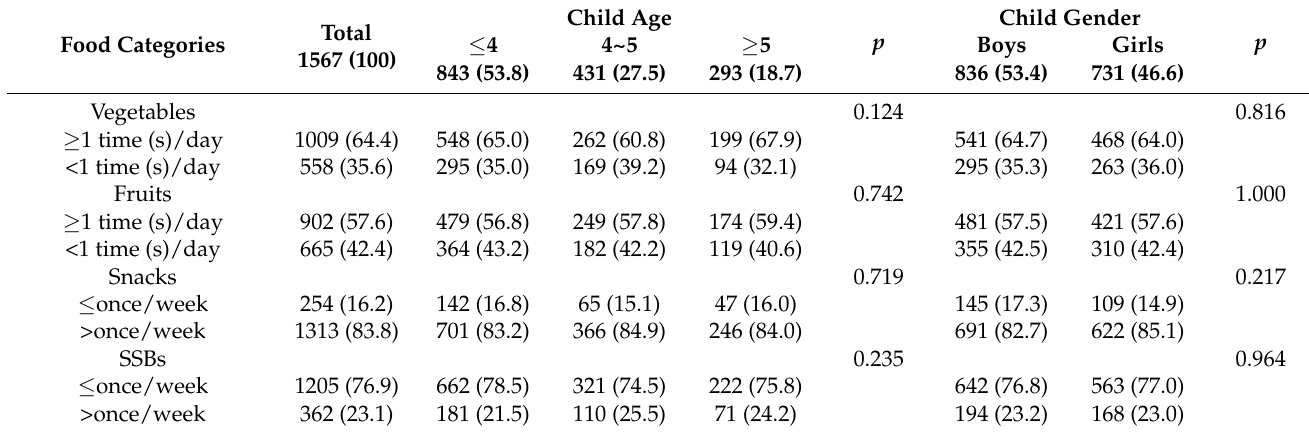
Table 2. Daily food consumption by children’s age and gender among preschoolers ( n = 1567, n (%)).